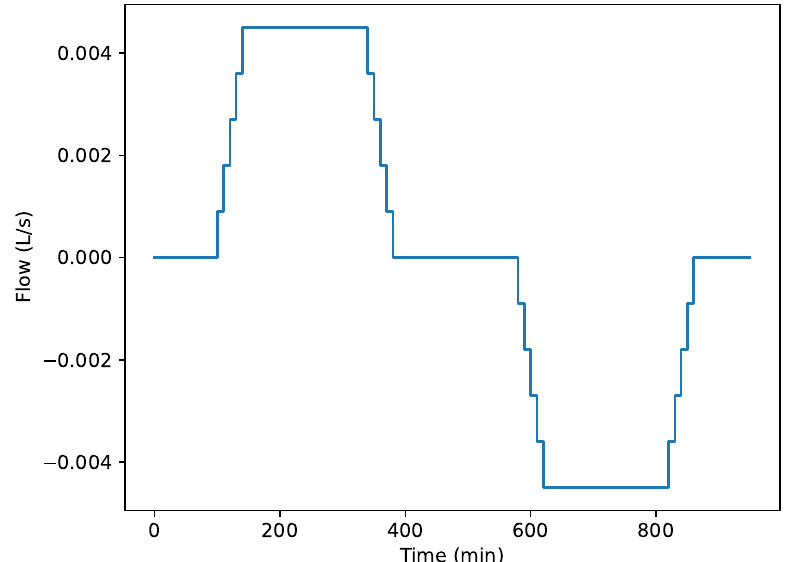
Figure 5. Generated trajectories of the disturbance of the flue gas flow rate signifying ramping up and ramping down operations of a power